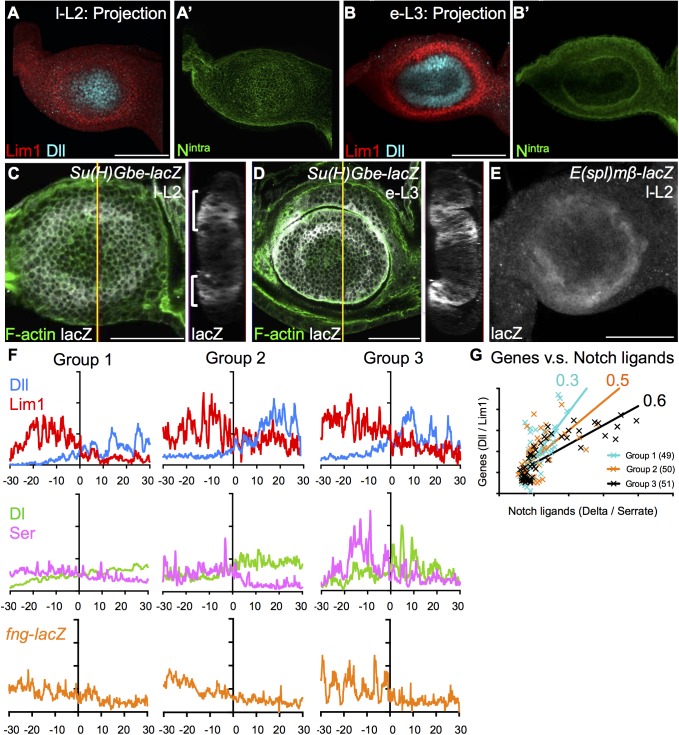
Notch activation and differential expressions of Delta, Serrate and fng-lacZ precede epithelial fold.(A-E) N activation is indicated by Nintra, (A’, B’, green, shown in 3D projection) and the N transcriptional reporters Su(H)Gbe-lacZ (C, D, white) and E(spl)mβ -lacZ (E, white) in an antennal disc from l-L2 (A,C, E) to e-L3 (B,D). Nintra is low and relatively uniform in l-L2 (A) and highly enriched at the Lim1/Dll expression border in e-L3 (B). (C, D) Su(H)Gbe-lacZ shows a circular pattern before (C, l-L2) and after (D, e-L3) A1 fold. In the cross section, as shown on the right for C and D, the reporter intensity is strongest at the center of the putative fold and gradually declines in surrounding cells (marked by brackets). (E) E(spl)mβ-lacZ expression also appears in a circular pattern, corresponding to the future A1 fold at l-L2. (F) Expression of the selector genes Lim1 (red) and Dll (blue), the N ligands Dl (green) and Ser (magenta), as well as fng-lacZ (orange) were analyzed prior to tissue fold in three groups of discs of increasing size putatively representing increasing developmental time. Pixel profiling shows clear segregation of Dll/Lim1 expression in groups 1, 2 and 3. Segregation of Dl/Ser expression only begins in group 2 and becomes clear in group 3. Dl is high in the central (Dll-expressing) region, and Ser is high in the peripheral (Lim1-expressing) region. fng-lacZ exhibits only a slightly elevated level in the peripheral region of group 1, but becomes higher in the peripheral compared to the central region of group 3 (see S7 Fig for raw images). (G) Ratios of Dll/Lim1 and Delta/Serrate from single cells are plotted for group 1 (green, N = 49), group 2 (orange, N = 50), and group 3 (black, N = 51). Regression lines from the three stages show a positive correlation, with increasing correlations over development time (compare R2 indicated next to the regression lines). Scale bars: 50μm.